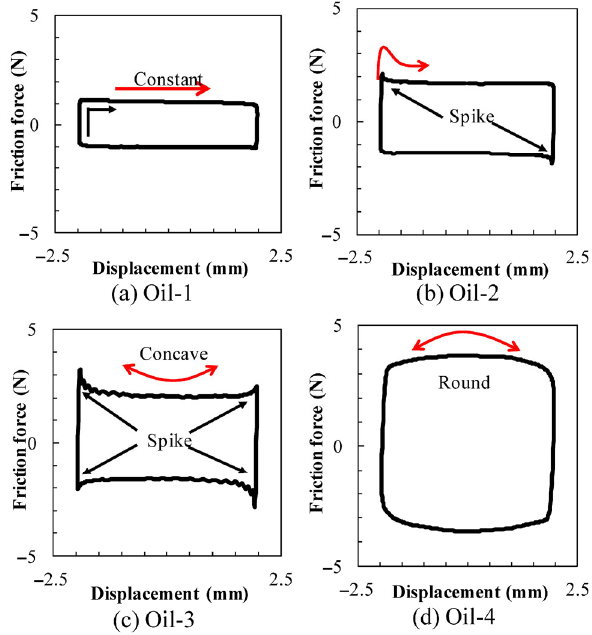
Fig. 3 Dynamic friction patterns measured using each lubricant at an amplitude of ±2.0 mm: (a) Oil-1, (b) Oil-2, (c) Oil-3, and (d) Oil-4.